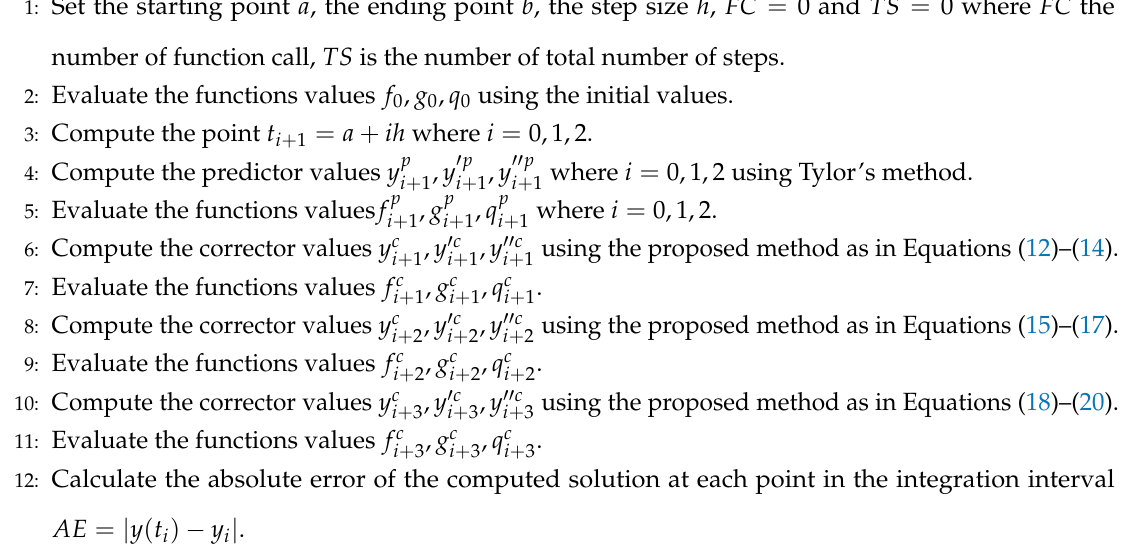
Algorithm 1 The procedure to solve the third-order ODEs by using the new method. 1: Set the starting point a , the ending point b , the step size h , FC = 0 and TS = 0 where FC